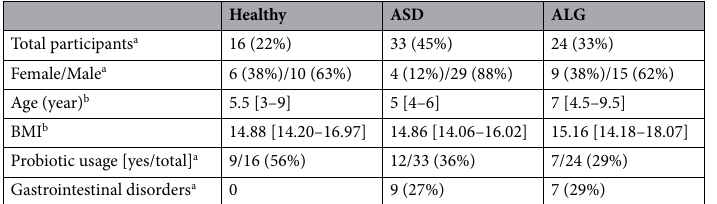
Table 1. Summary of subject characteristics. ALG allergies, ASD autism spectrum disorders, BMI body mass index. a Number of cases (percentage). b Median [interquartile range].